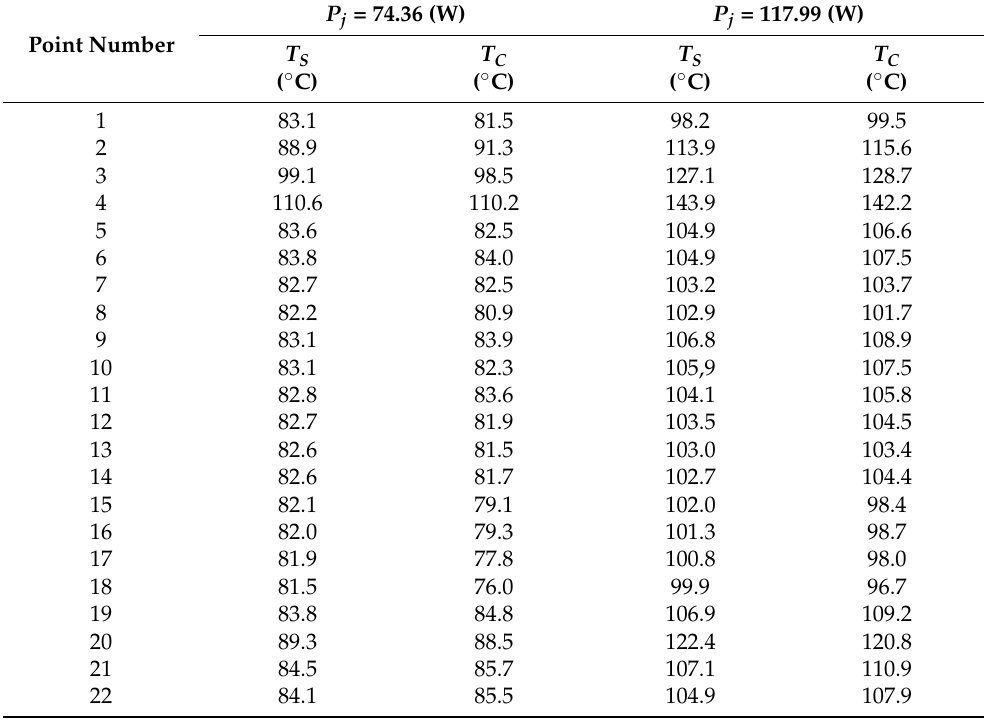
Table 5. The temperature values obtained from T S simulations and T C measurements for each of the points presented in Figure 2 for P j = 74.36 W and P j = 117.99 W.